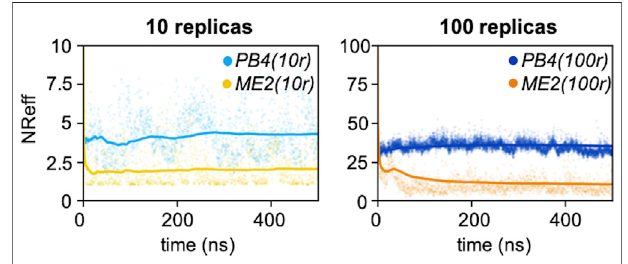
FIGURE 3 | Number of effective replicas as a function of the simulation timeforPB4(10r),ME2(10r),PB4(100r)andME2(100r)simulations.Thedots represent the value at the exact time, while the straight lines indicate the cumulative